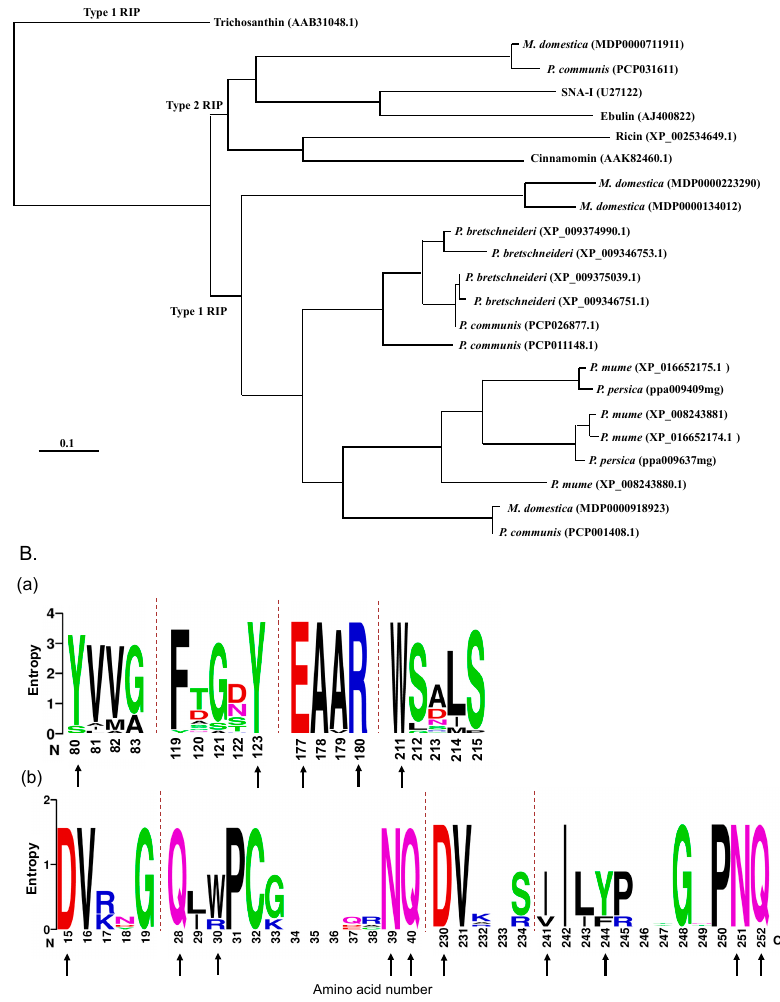
Figure 1. Sequence analyses of RIPs. ( A ) Phylogenetic tree of sequences encoding RIP domains from Rosaceae, Ricinus communis , Sambucus nigra , Sambucus ebulus , Cinnamomum camphora , and Trichosanthes kirilowii . The phylogenetic tree was made by using constraint-based alignment tool (COBALT). The name and species of Rosaceae RIPs and accession numbers are indicated; ( B ) (a) Logo representation of the amino acid sequence alignment of RIP domains presented in the phylogenetic tree. The size of the letters is proportional to the frequency of the amino acid at that position of the sequence. Residues reported to be important for the formation of active sites are indicated by black arrows [19]. Amino acid numbers refer to the sequence of ricin; (b) Amino acid conservation in the lectin domains of type 2 RIPs from Malus domestica , Pyrus communis, Sambucus nigra , Sambucus ebulus , and Ricinus communis . The conserved amino acids of the carbohydrate binding site are indicated by black arrows [20].